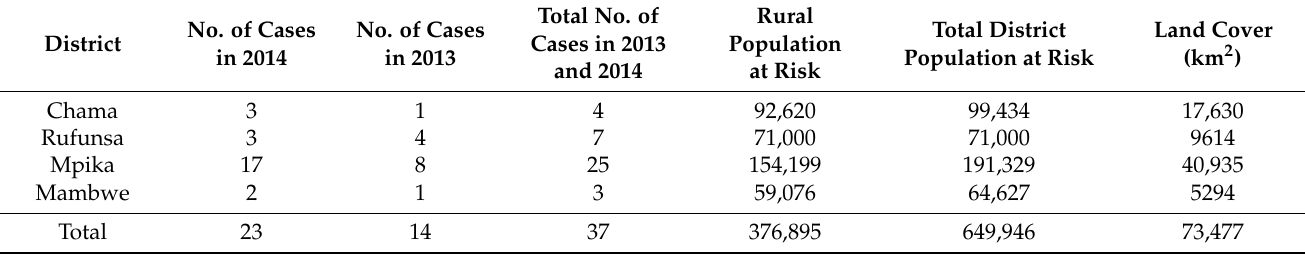
Table 2. The population at risk of contracting rHAT and associated land cover area.